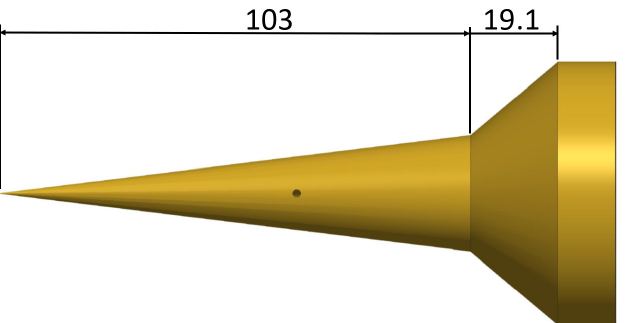
Figure 2. Cone/flare model geometry (dimensions are in mm) (from Running and Juliano [42]). Simultaneous wind-on measurements of surface temperature and PSP intensity were sampled at 355 Hz and 20 kHz with an infrared camera (InfraTec 8300 hp, Dresden, Germany) (640 × 512 pixel resolution) and high-speed camera (Phantom V2512, Wayne, NJ, USA) (640 × 480 pixel resolution), respectively. The infrared camera measured the surface temperature of the anodized-aluminum frustum and flare on one half of the model while the high-speed camera measured the the PSP intensity on the other half. Both